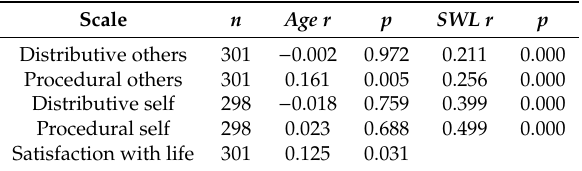
Table 2. Correlations of age with belief in a just world (BJW) and life satisfaction measure (SWL) and between BJW and SWL. Scale